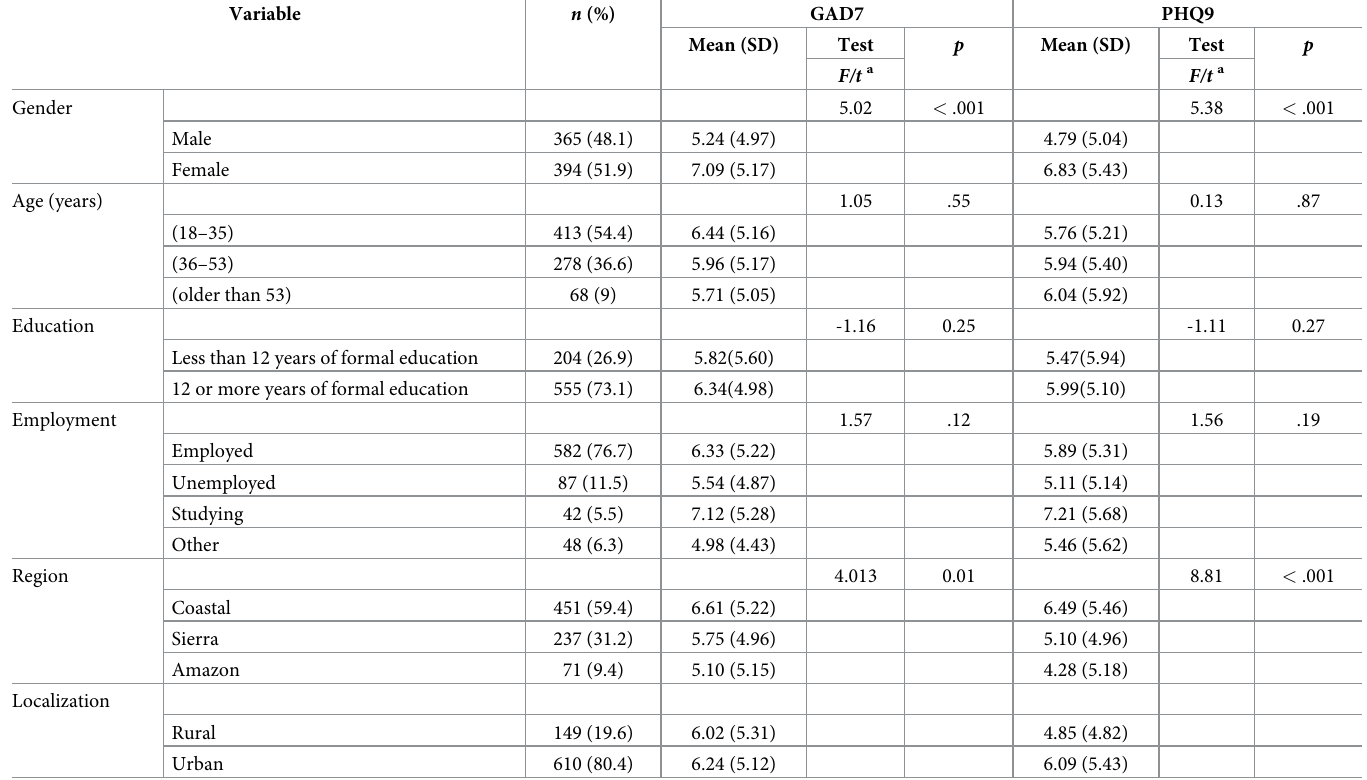
Table 1. Sociodemographic information and group differences of GAD-7 and PHQ-9 sum scores.